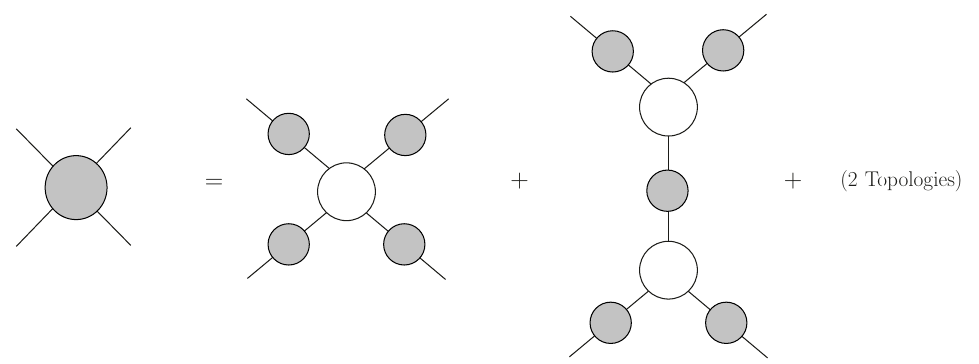
] in the first term and the third c